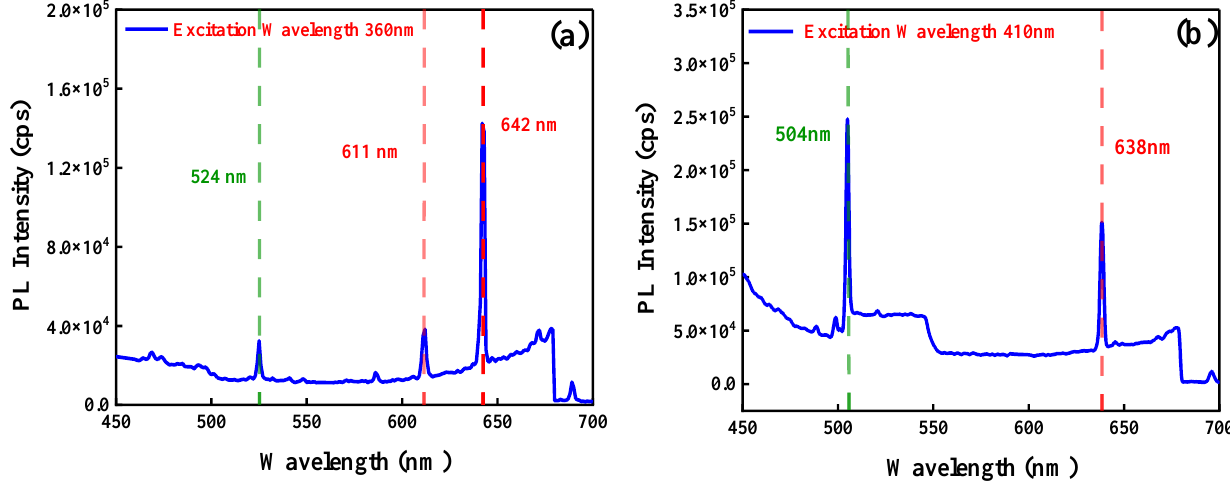
Figure 10. ( a ) PL spectra of CdS at 360 nm excitation wavelength; ( b ) PL spectra of CdS at 410 nm excitation wavelength.